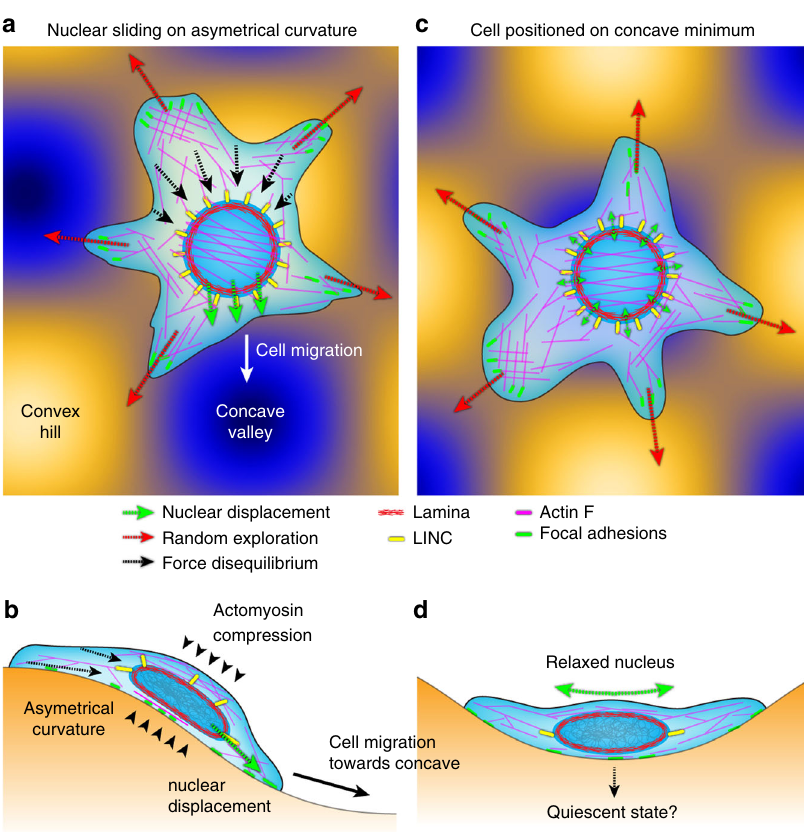
Fig. 7 A model for curvature-guided cell migration. a , c Adhesion on asymmetrical curvature ( a ) triggers nuclear sliding toward concave, altering the random walk of the cell and leading to cell positioning on concave valley ( c ). b , d Side views showing actomyosin compression of the nucleus and its relaxation on concave